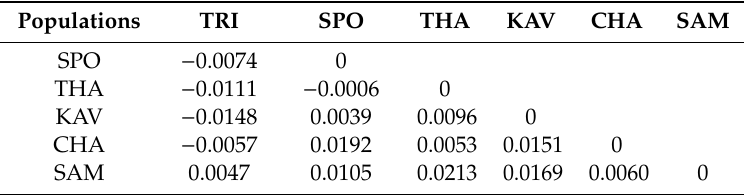
Table 2. F ST pairwise values of the white seabream populations within the Aegean